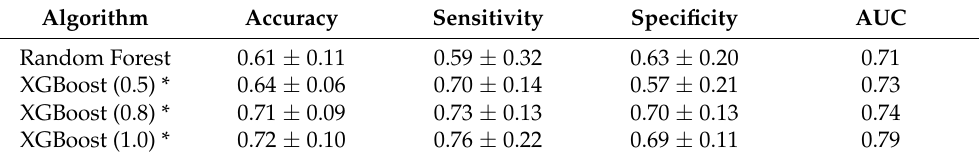
Table 2. Comparison of Random Forest and XGBoost Values. The values of the subsamples (0.5, 0.8, 1). The n_estimators (400)_ max_depth (20)_ learning rate (0.1) are the same in each subsample. Algorithm